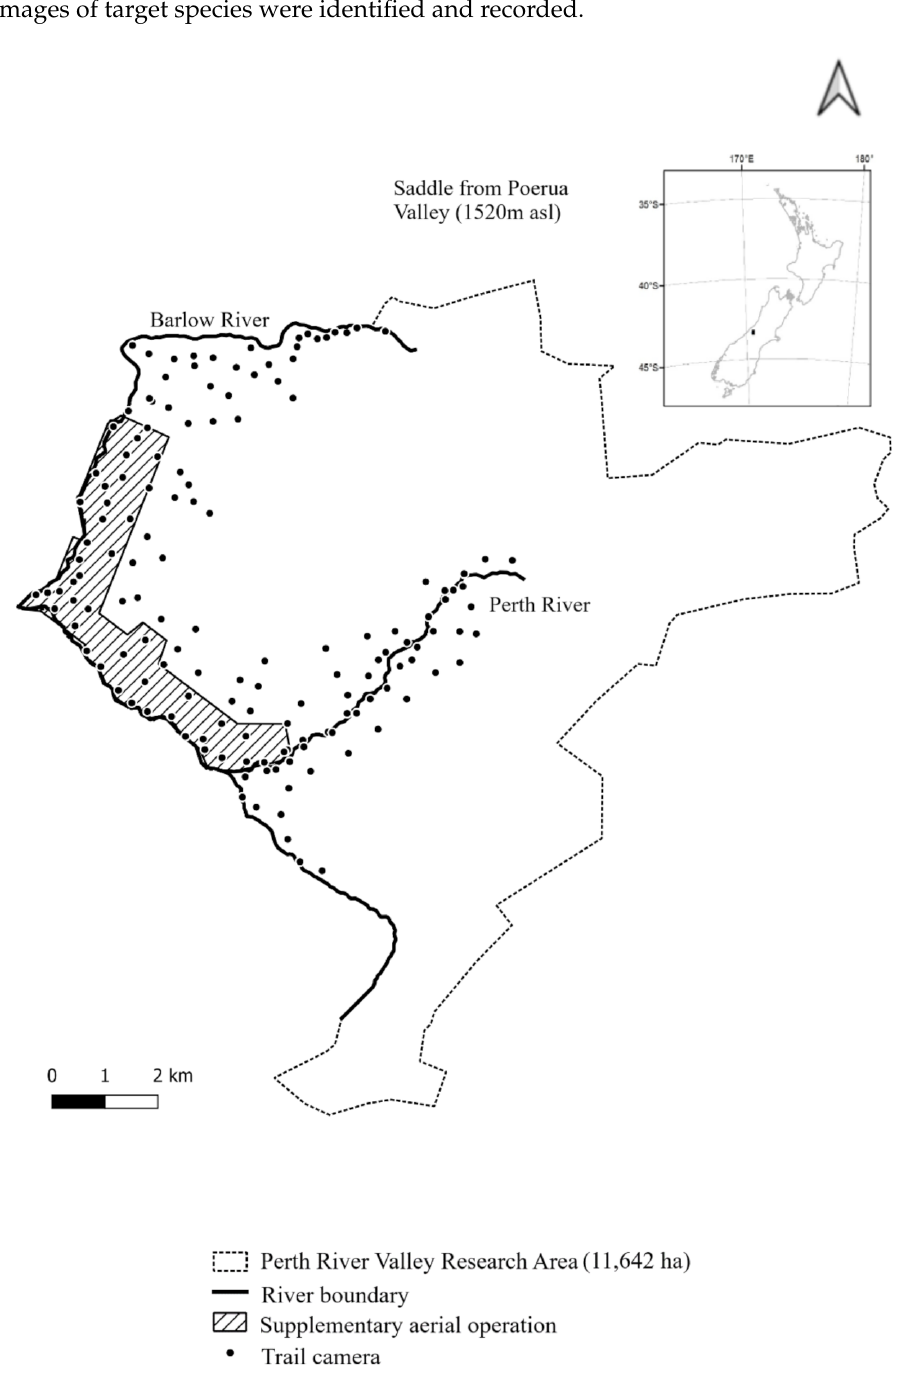
Figure 1. Study site showing trail camera locations, protective river boundaries and the supplemen- tary aerial treatment